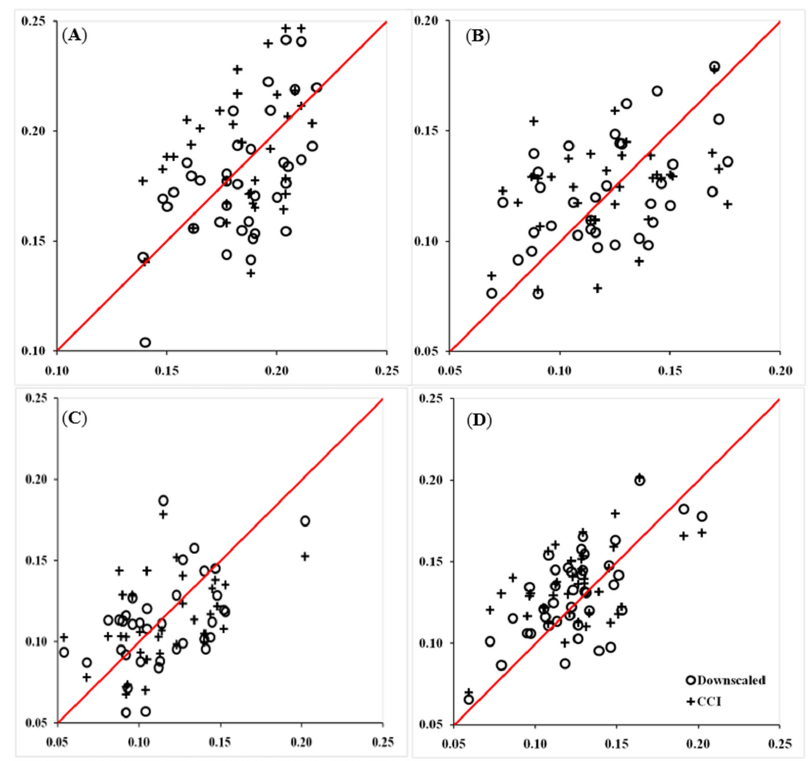
Figure 4. Scatterplot comparisons of in situ SM data (x-axis, cm 3 /cm 3 ) versus the downscaled SM data (y-axis, circle-indicated, cm 3 /cm 3 ) and the original CCI SM data (y-axis, cross-indicated, cm 3 /cm 3 ) on 1 May ( A ), 21 May ( B ), 1 June ( C ), and 11 June ( D